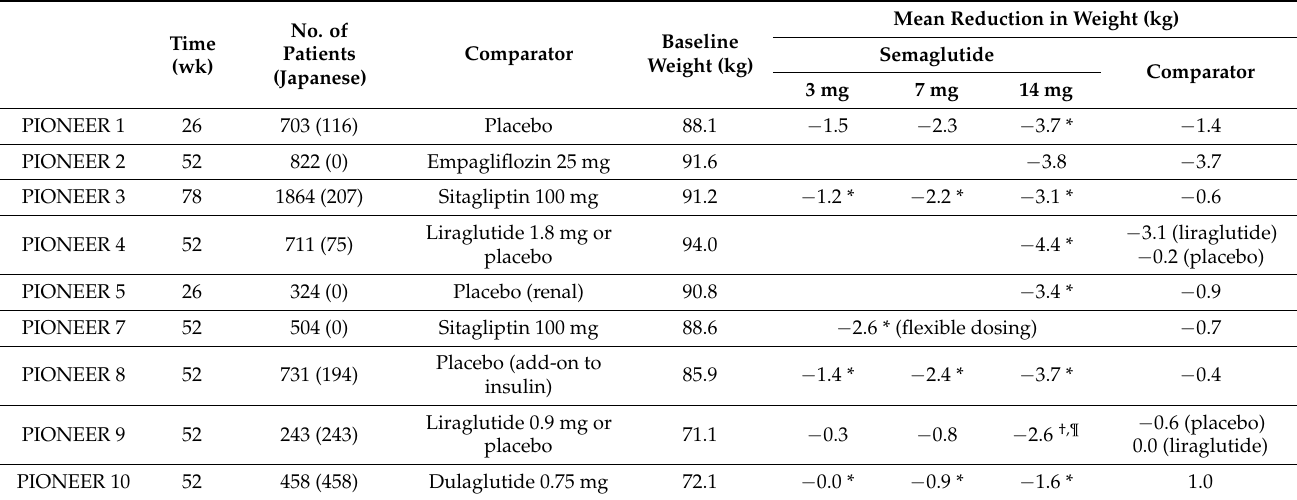
Table 2. Summary of efficacy in weight reduction across the PIONEER trials